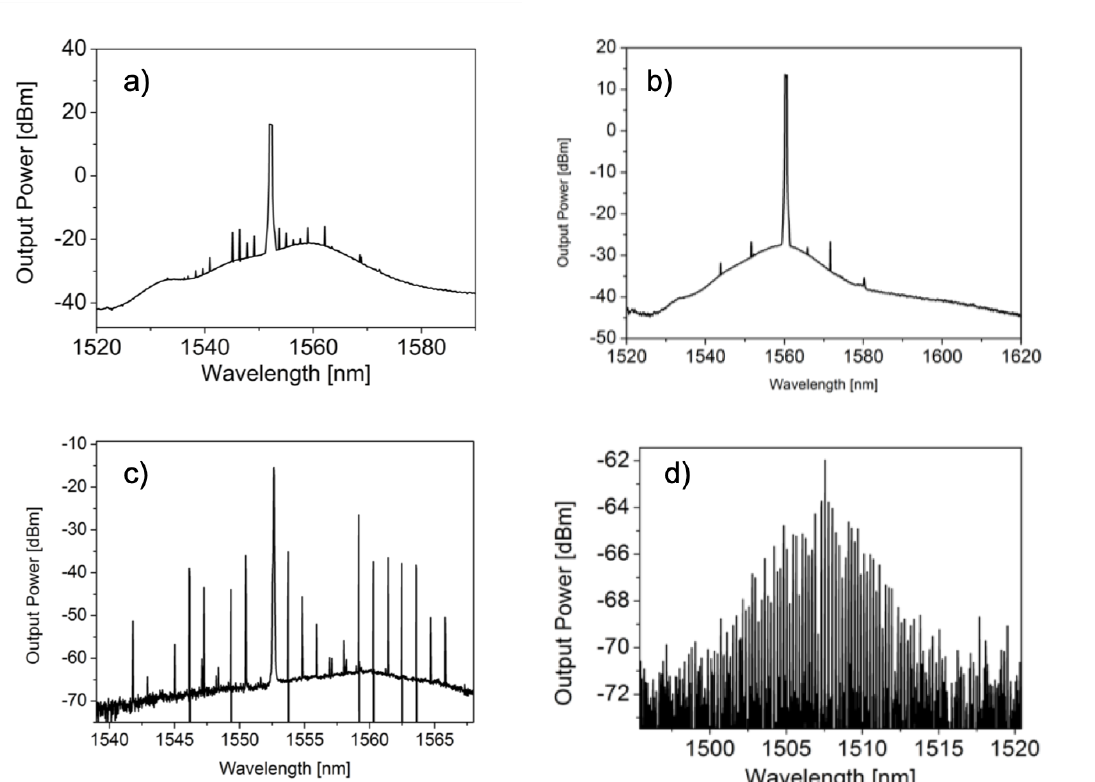
Figure 5. Experimental spectra of: ( a ) a Type I comb, with a frequency offset of 1 FSR, ( b ) a Type II comb, with a frequency offset of 5 FSR, ( c ) FWM in the vicinity of the pump spaced by azimuthal FSR and ( d ) Modulation intensity around the anti-stokes component at 1508 nm , with a frequency offset of 2 vertical FSR (2X0, 12 nm) measured for a microbubble of 475 µ m diameter. Reproduced with modifications from Adapted with permission from Ref. [50] c (cid:13) The Optical